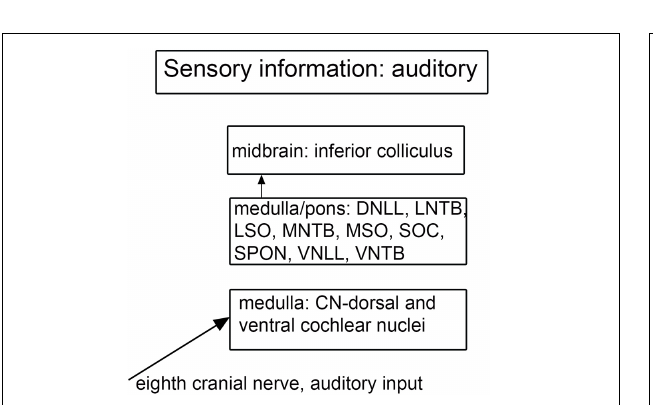
FIGURE 7 | Schematic showing the main brainstem nuclei of the auditory system. CN, cochlear nuclei; DNLL, dorsal nucleus of the lateral lemniscus; MNTB, medial nucleus of the trapezoid body; MSO, medial superior olive; SOC, superior olivary complex; SPON, superior paraolivary nucleus; VNLL ventral nucleus of the lateral lemniscus; VNTB, ventral nucleus of the trapezoid body.